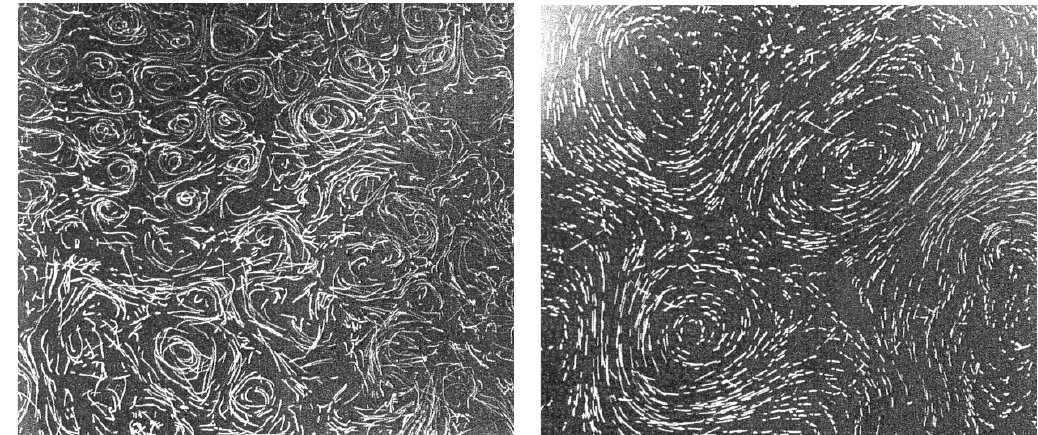
Fig. 6. Streak photography images of small-scale turbulence (in this case, the graphs are for two-dimensional turbulence). The graphs refer to different conditions of stability; from Hopfinger (1987), who adapted it from Maxworthy et al. (1985).